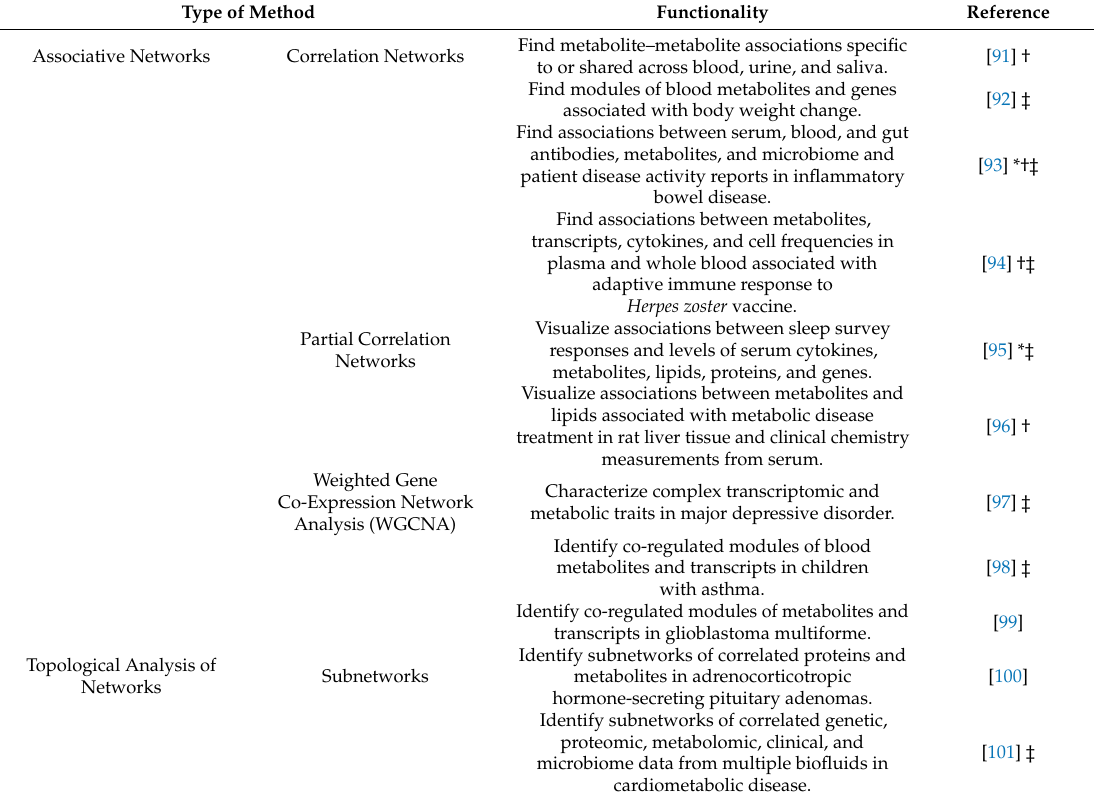
Table 2. Examples of multi-omics applications using co-regulation